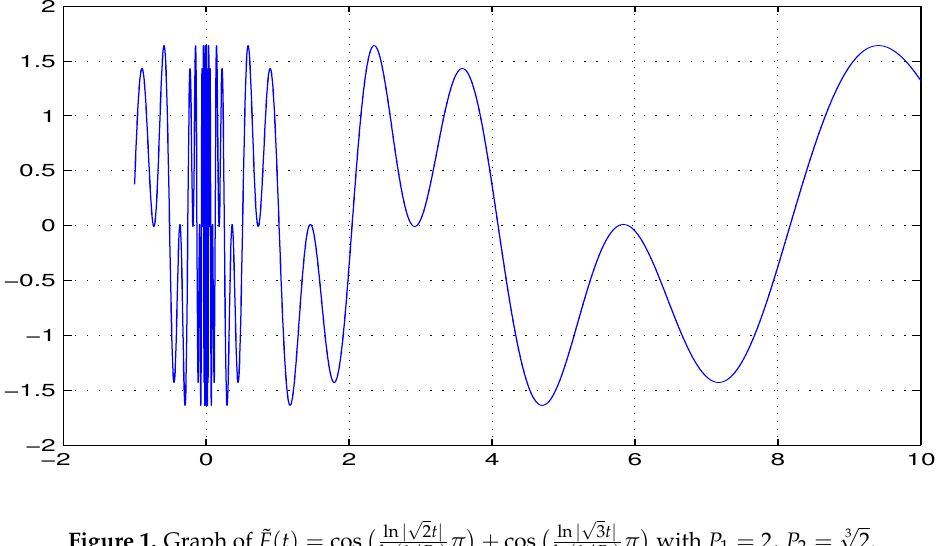
Figure 1. Graph of ˜ F ( t ) = cos